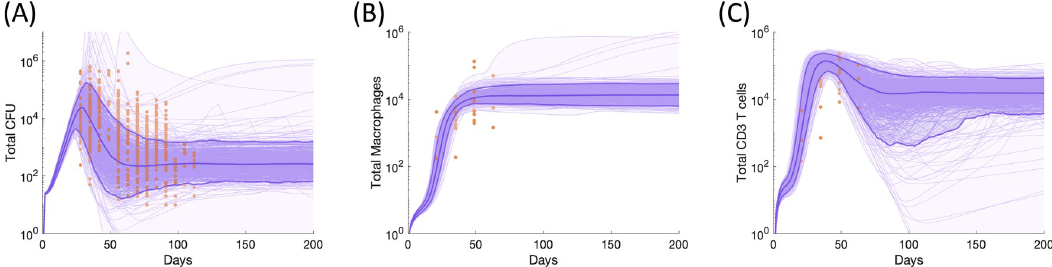
Fig 4. Bacteria, macrophage and T cell dynamics within an individual granuloma. Individual NHP granuloma bacteria (A) , macrophages (B) , and CD3+ T cells (C) shown as orange points across time. Each individual point represents data from a single NHP granuloma. Purple lines indicate simulation outputs from 500 simulations that match NHP data. Light purple shading shows the minimum and maximum of simulation runs, darker purple shading represents the 5 th to 95 th percentiles of the simulations, and dark purple lines represent the 5 th , 50 th , and 95 th percentiles of simulations. Parameter ranges are listed in S1 Table.